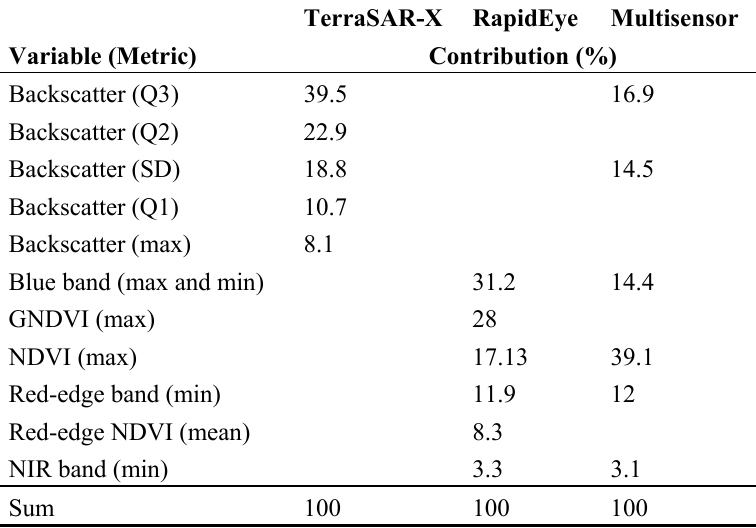
Table 4. Importance of the explanatory variables in the ME